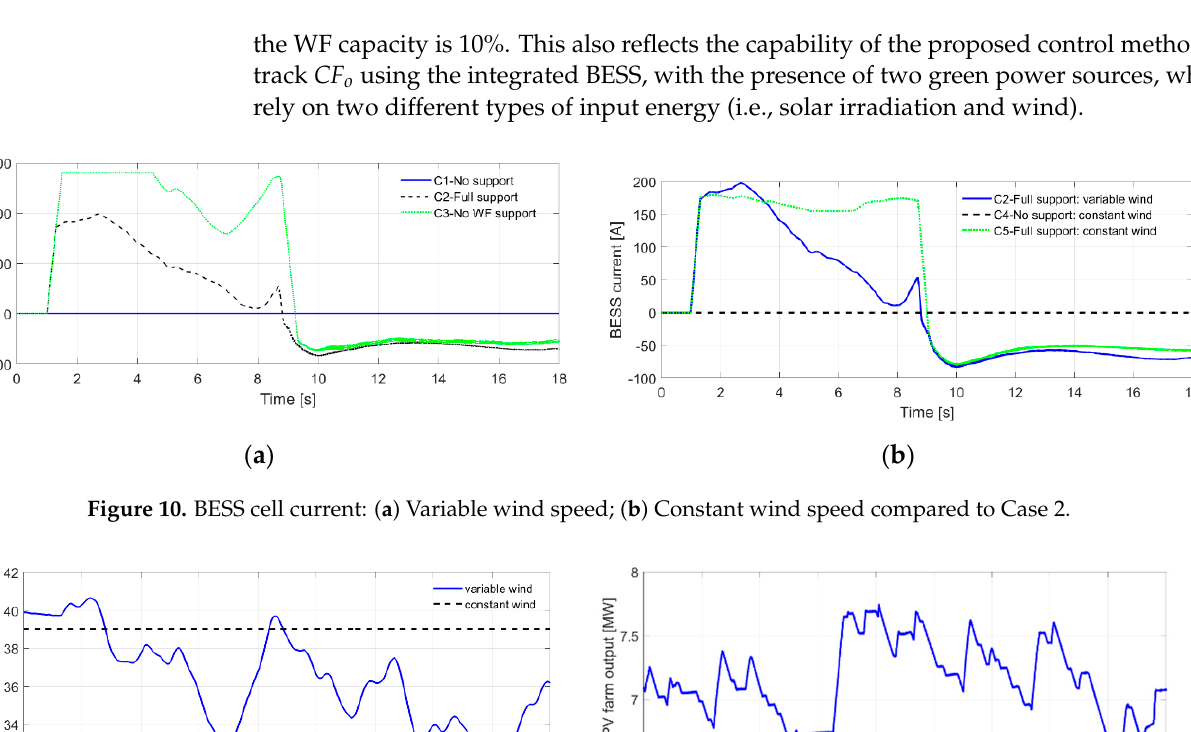
Figure 10. BESS cell current: ( a ) Variable wind speed; ( b ) Constant wind speed compared to Case 2. Figure 11. Output power: ( a ) wind farm under conventional operation; ( b ) PV farm under conventional operation.